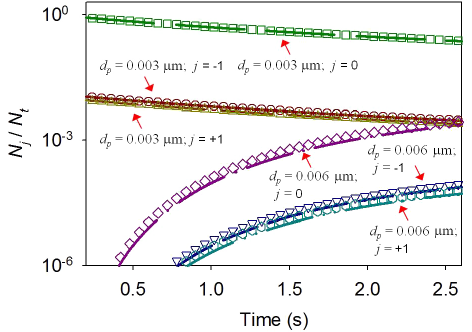
Figure 6. Charge accumulation rate of 137 Cs particles for each charging mechanism ( d p = 0 . 82µm; A Cs-137 = 12 . 8mBq; q I = 7 . 1 × 10 6 m − 3 s − 1 ) . The assumptions used in Eq. (8) were applied to evaluate the validity of the equation. A Cs-137 corresponds to the self-charging rate of the radioactive particles.